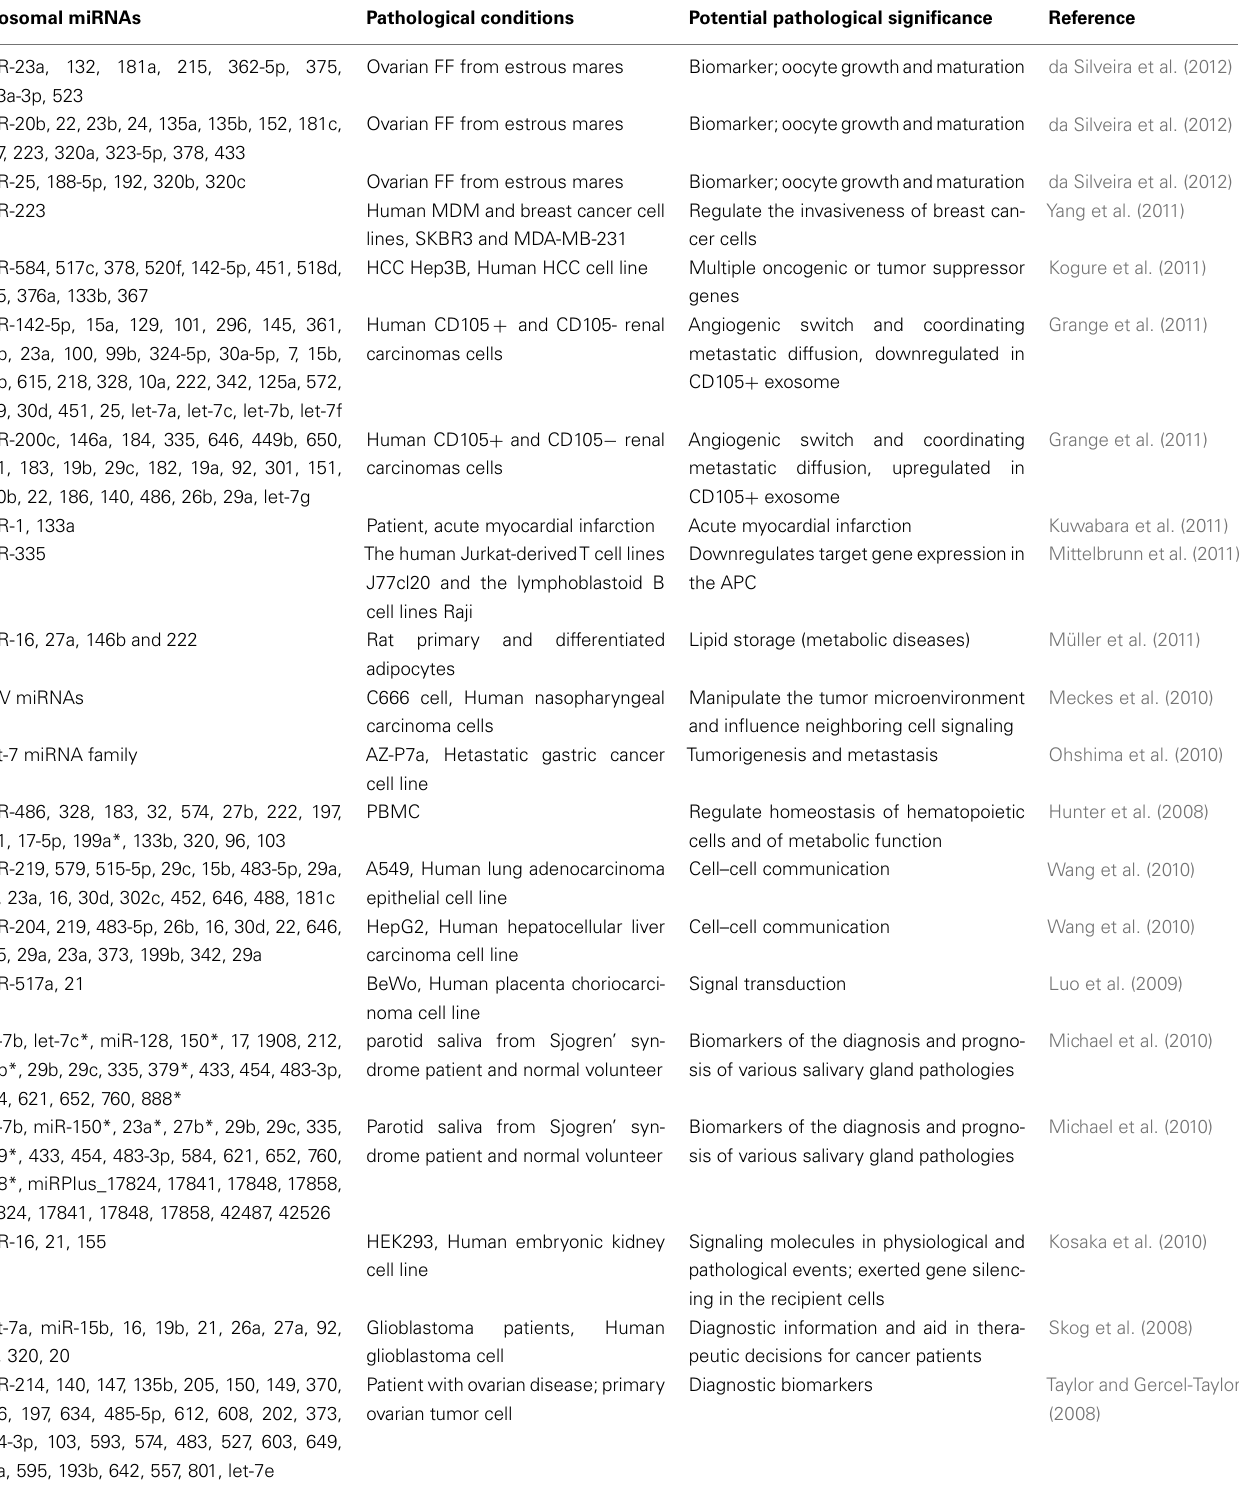
Table 1 | Exosomal miRNAs as potential biomarkers and therapeutic targets Exosomal